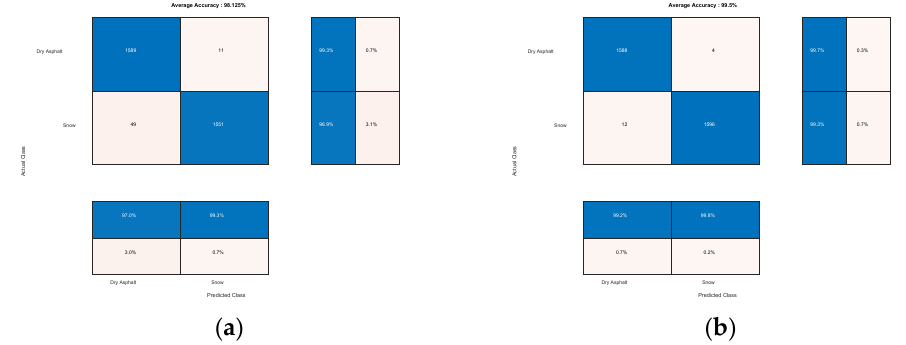
Figure 13. Test results for TPIN signals using CNN architecture for classification of road surfaces and tires: ( a ) front-wheel data; ( b ) rear-wheel data.